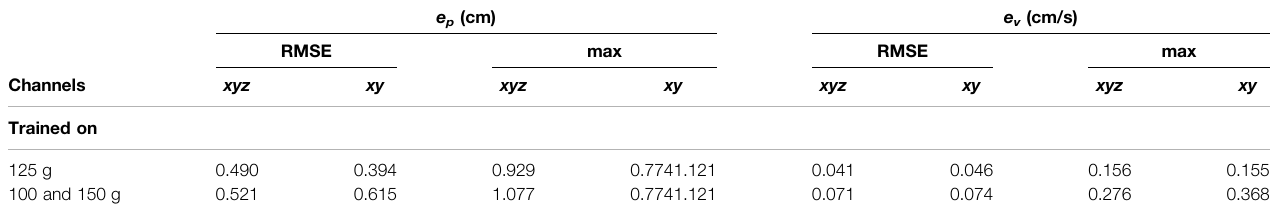
TABLE 5 | Position and velocity RMS testing errors for the box-shaped object with a weight of 125 g when training using data corresponding to the target weight (125 g) or the combination of weights (100 and 150